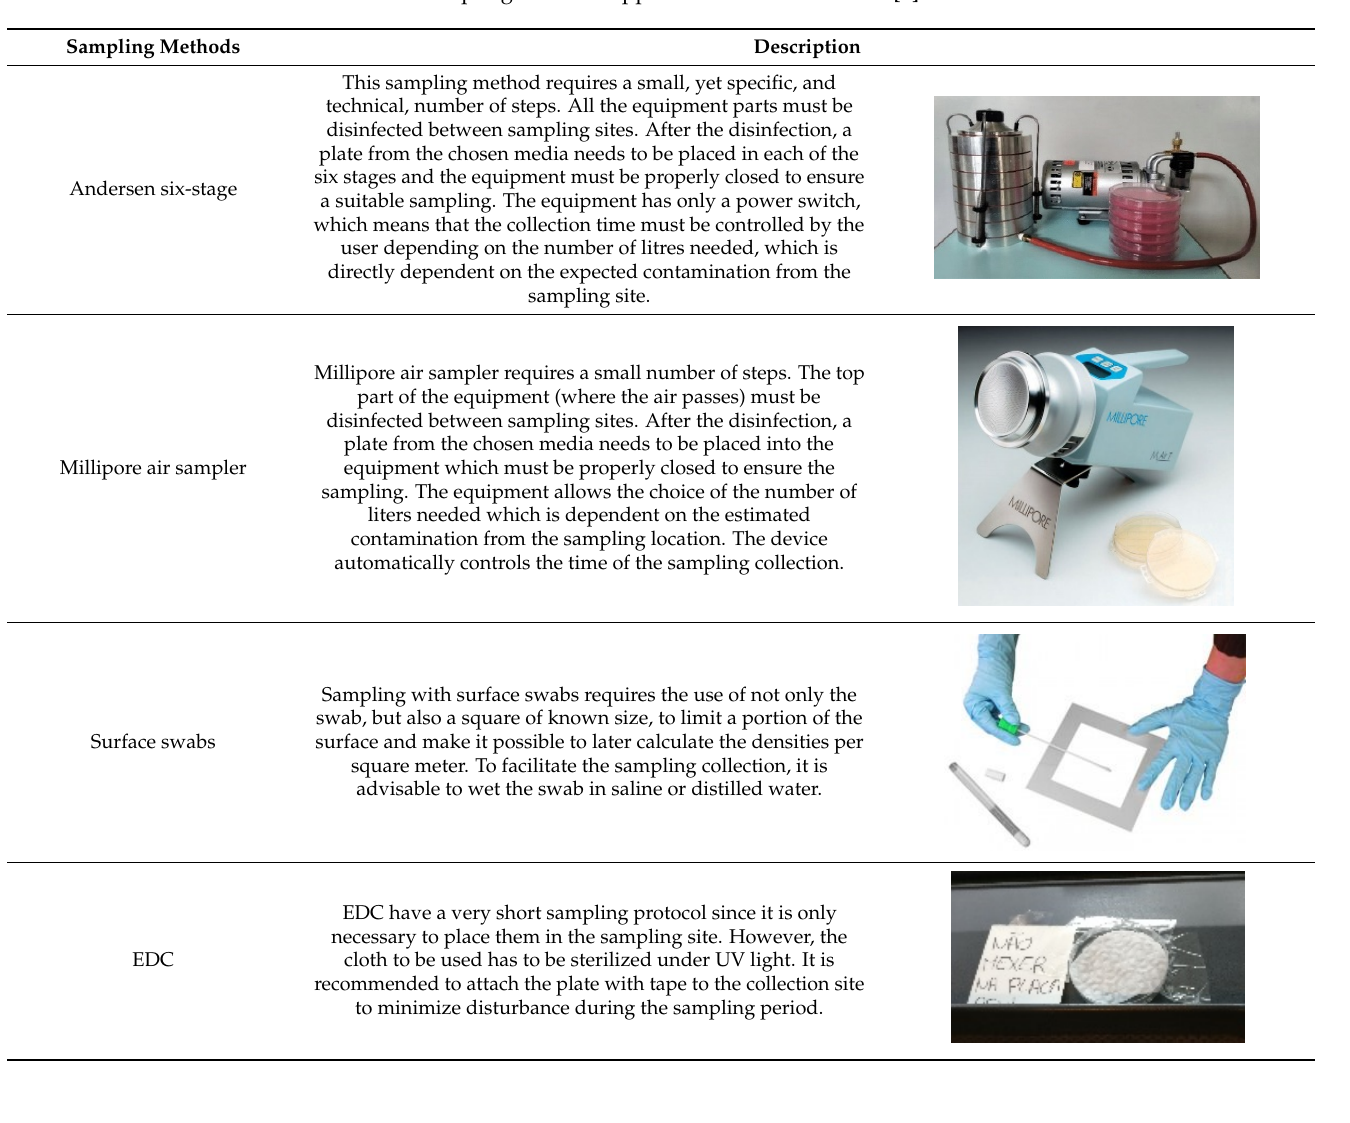
Table 1. Sampling methods applied in the assessed FFH [4].